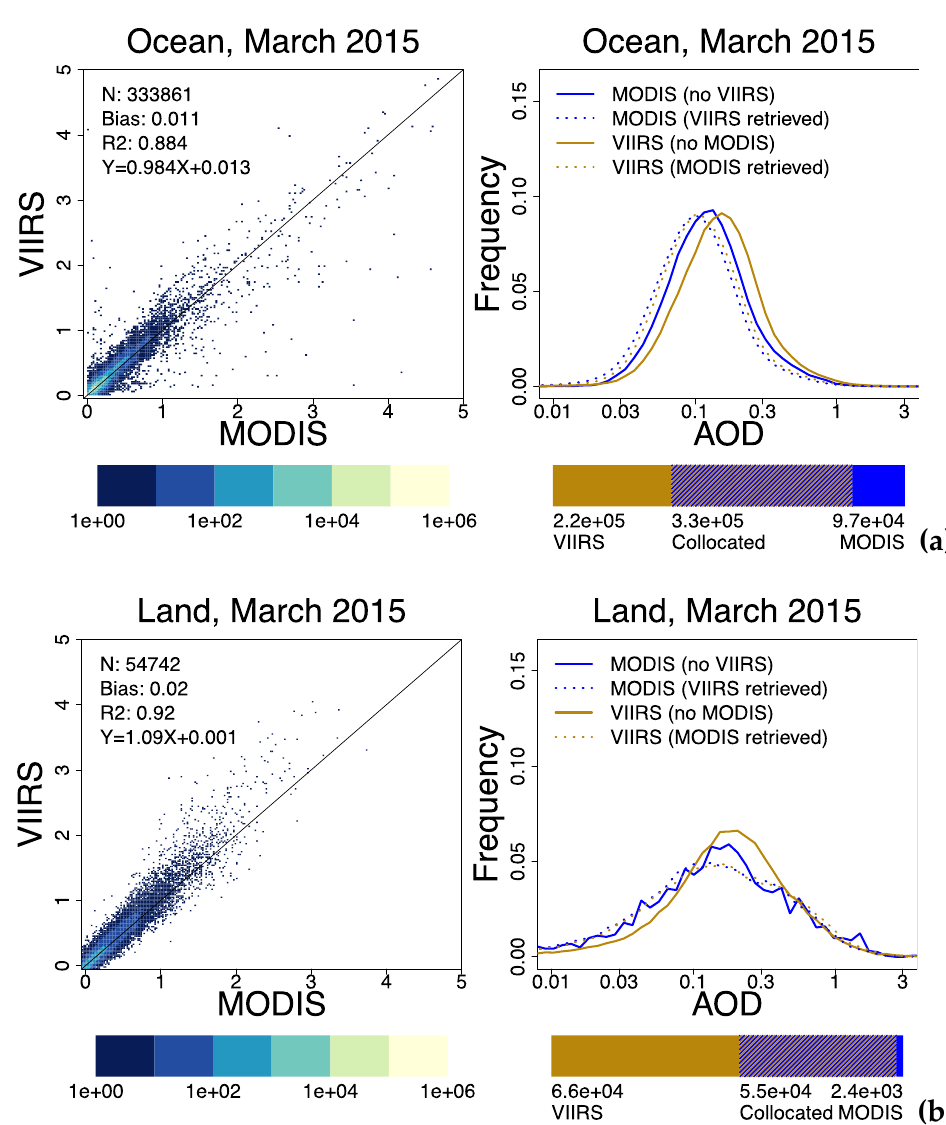
Figure 13. Comparison of all 0.55 µ m AOD daily average one-degree grid cells from March 2015. Left, scatterplots of collocated MODIS Aqua and VIIRS SNPP cells; right, histogram frequencies where MODIS and VIIRS were collocated (dotted lines) and where only one sensor retrieved AOD (solid lines). The horizontal bar on the right indicates the number of collocated and non-collocated grid cells for each sensor. AOD values are ( a ) over ocean and ( b ) over land.